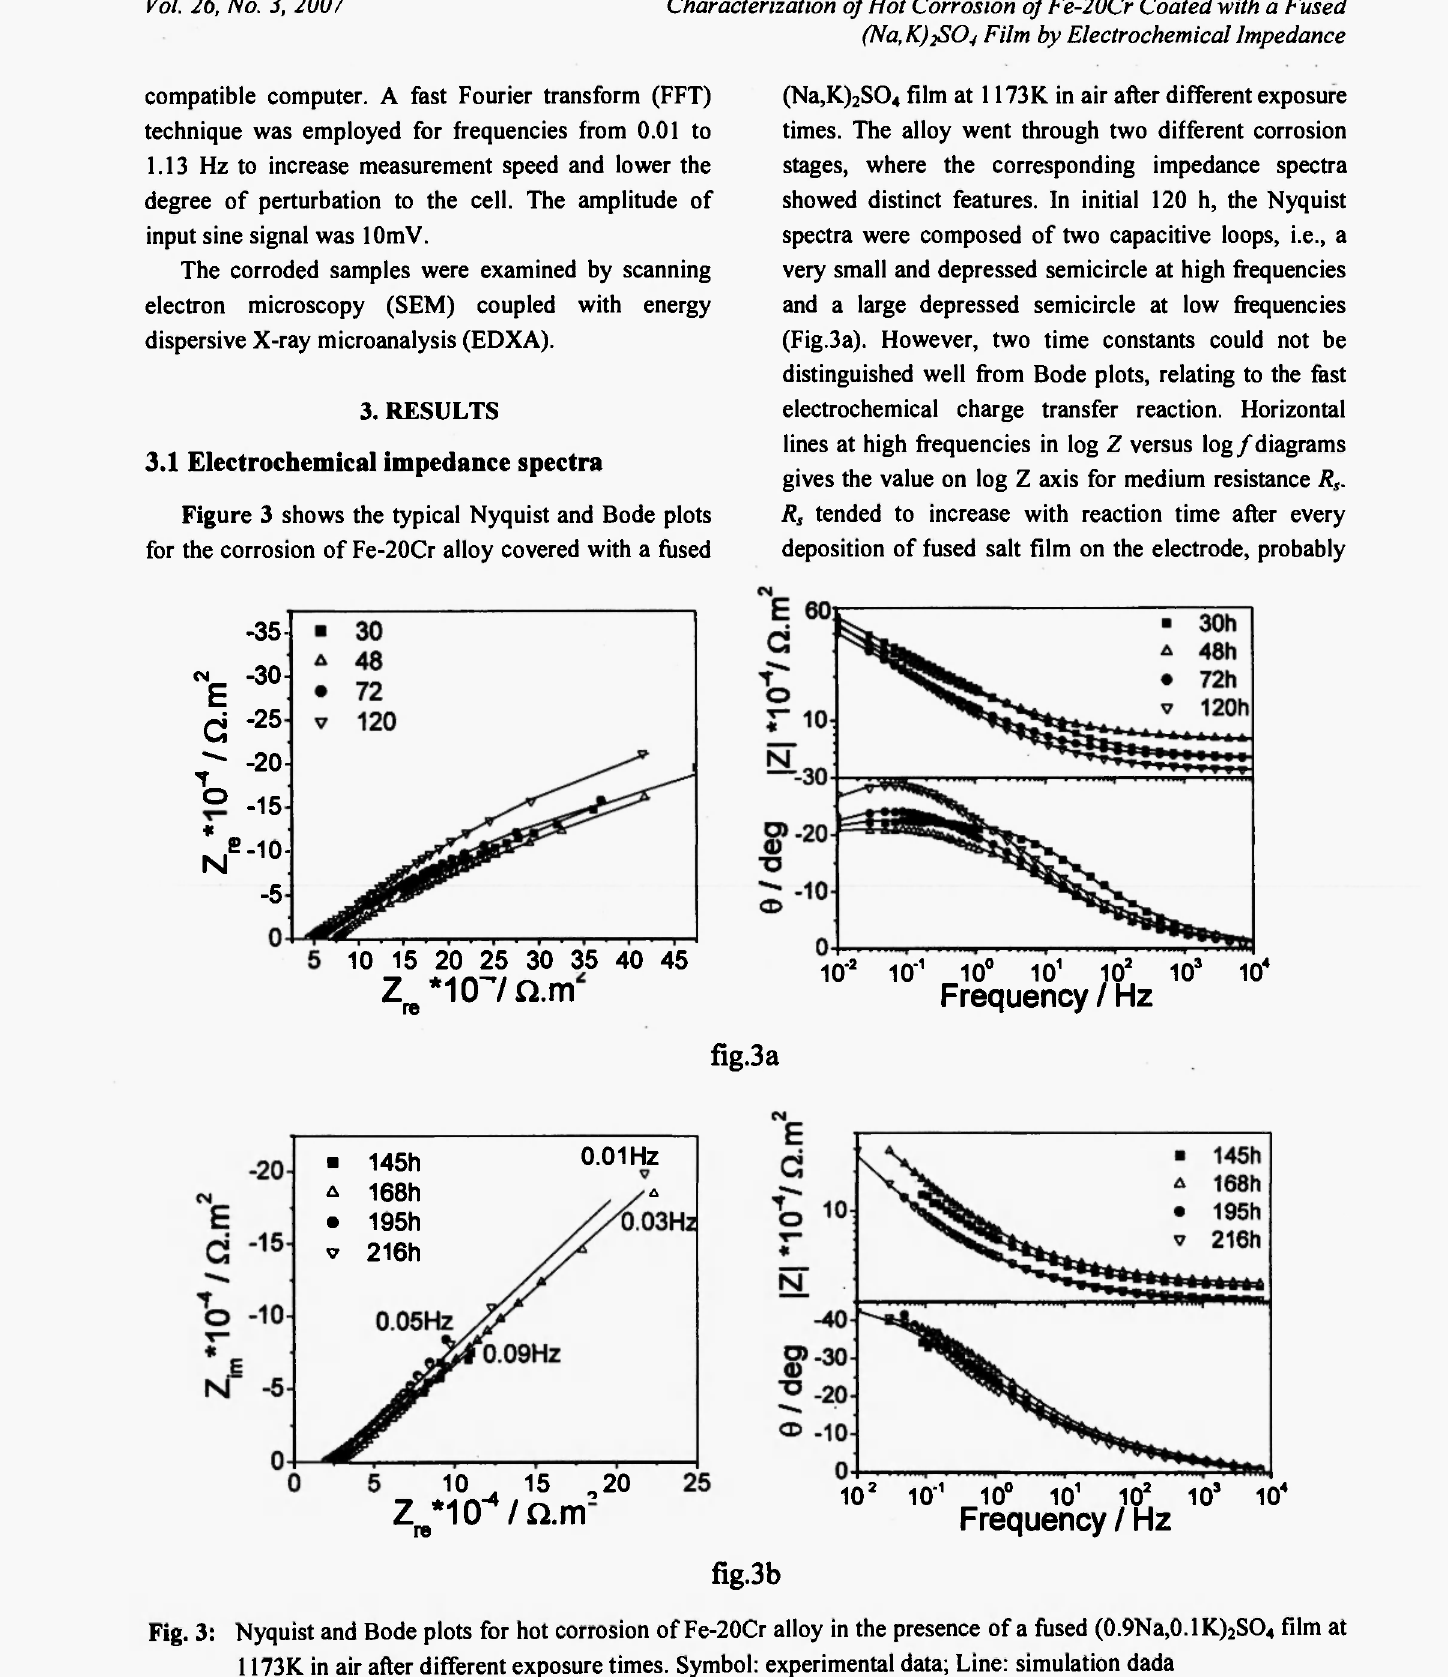
Fig. 3: Nyquist and Bode plots for hot corrosion of Fe-20Cr alloy in the presence of a fused (0.9Na,0.1K) 2 S04 film at 1173K in air after different exposure times. Symbol: experimental data; Line: simulation dada